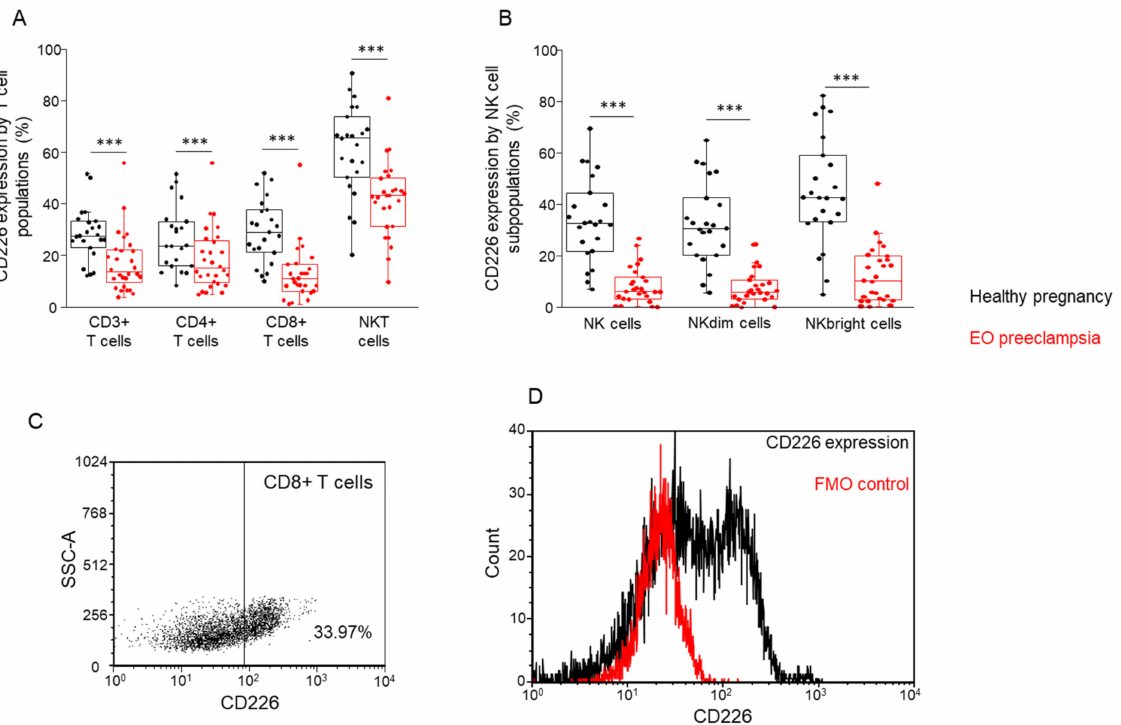
Figure 3. CD226 expression by the investigated T- and NK cell subpopulations in women with EO preeclampsia and healthy pregnant women. The expression of CD226 by different T- and NK cell subpopulations in the peripheral blood of women with early-onset preeclampsia and healthy pregnant women ( A , B ). The solid bars represent medians of 24 and 27 determinations, respectively, the boxes indicate the interquartile ranges, and the lines show the most extreme observations. Differences were considered statistically significant for p -values < 0.01 ***. Representative FACS plots show the expression of CD226 receptor by CD8+ T cells ( C ). To determine the positivity of the CD226 receptor, FMO control was used ( D